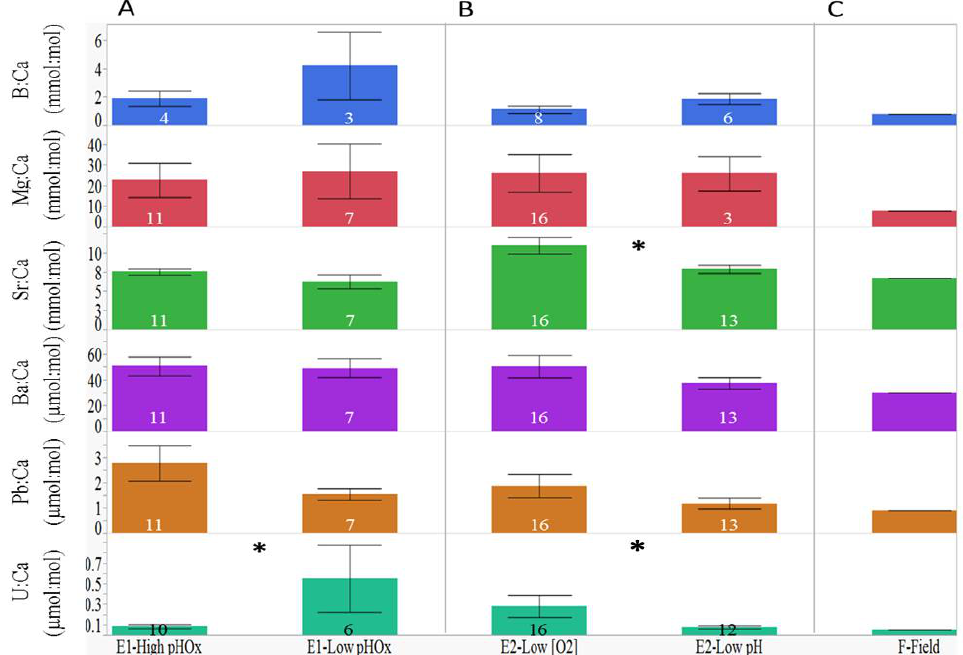
Figure 3. Element:Ca for each treatment analyzed. ( A ) Experiment 1: Low pHOx results in statoliths with high levels of U:Ca ( F = 16.86, p = 0.0005 ); ( B ) Experiment 2: 1, 3 Low [O ] results in a higher U:Ca concentration within statoliths in comparison to low pH 2 = 5.91, p = 0.0225 ) and higher Sr:Ca concentrations ( F = 6.47, p = 0.0174); ( F 1, 6 1, 6 ( C ) Field values are from a single capsule that developed in the field. Treatments were tested using one-way ANOVA. Number within column = Number of capsules analyzed. * Significant. Bar = ±1 standard error from the